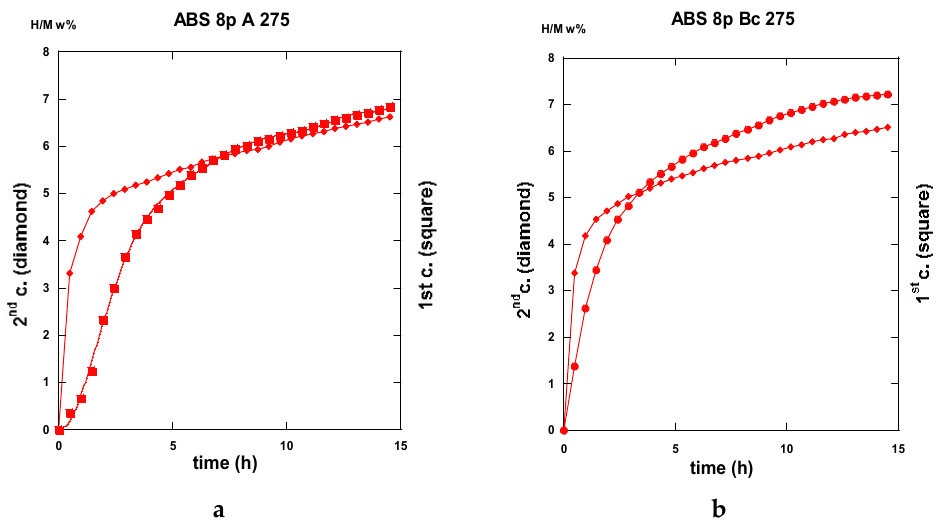
Figure 29. Comparison of the traces in terms of the 1st and 2nd absorption rates (H/M w%) of 8 passes ECAP-treated samples at 275 °C: a —mode A, b —mode B C.